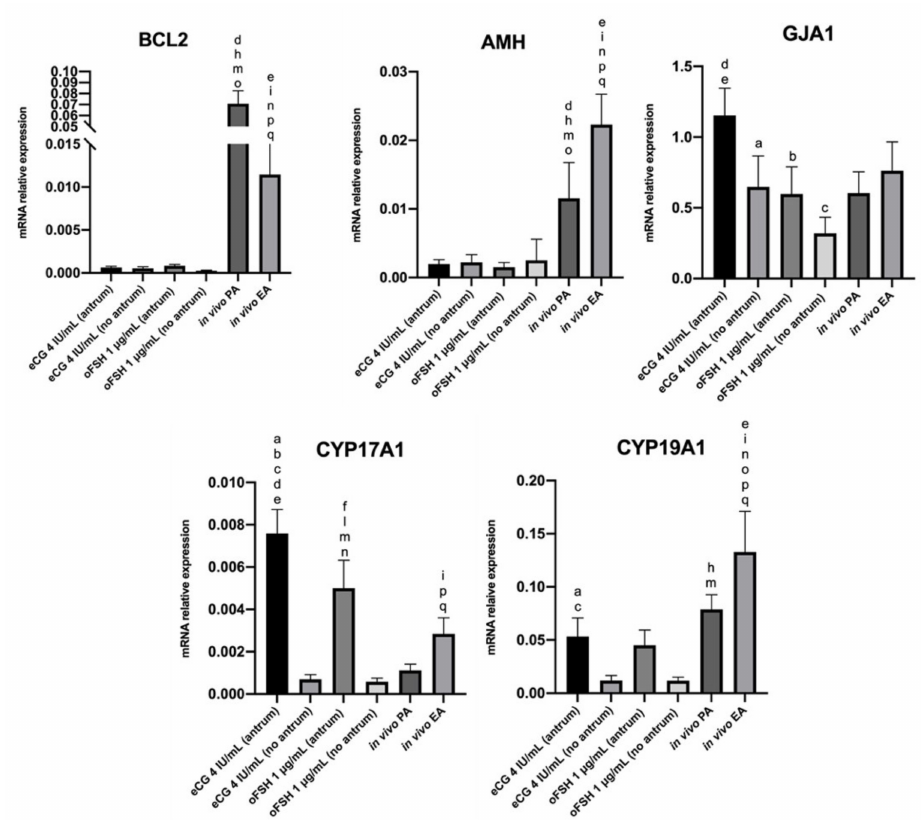
Figure 6. Representative expression of steroidogenic and somatic-specific genes. Letters indicate significant differences between a eCG 4 IU/mL (antrum) vs. eCG 4 IU/mL (no antrum); b eCG 4 IU/mL (antrum) vs. oFSH 1 µ g/mL (antrum); c eCG 4 IU/mL (antrum) vs. oFSH µ g/mL